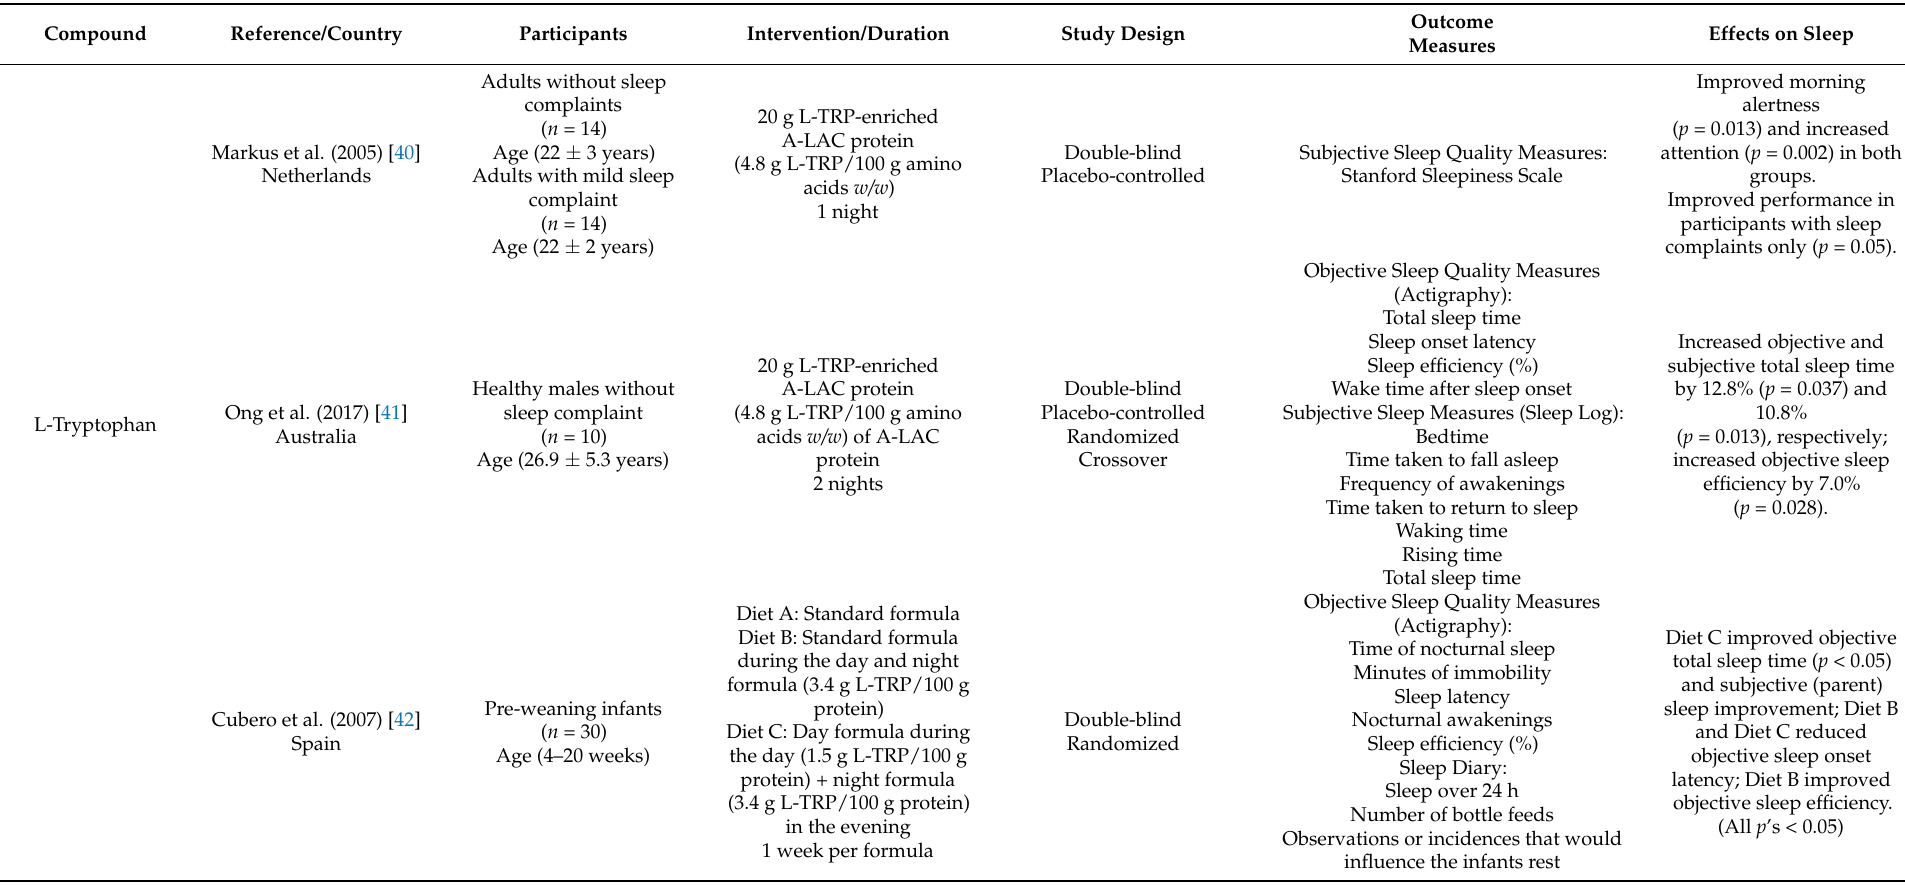
Table 1. Selected nutraceuticals used in the promotion and improvement of quality of sleep and their outcomes in different population